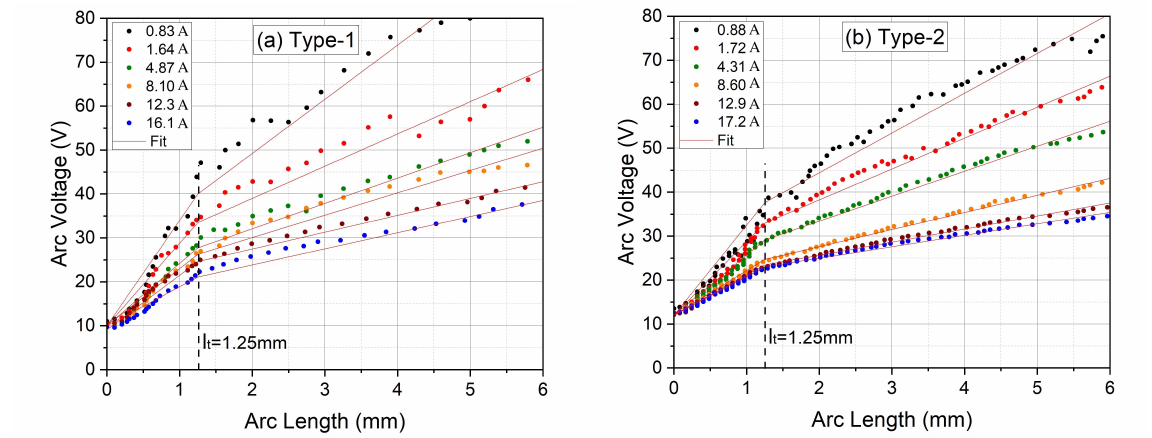
Figure 11. Arc voltage as a function of arc length for Type-1 and Type-2 contacts.